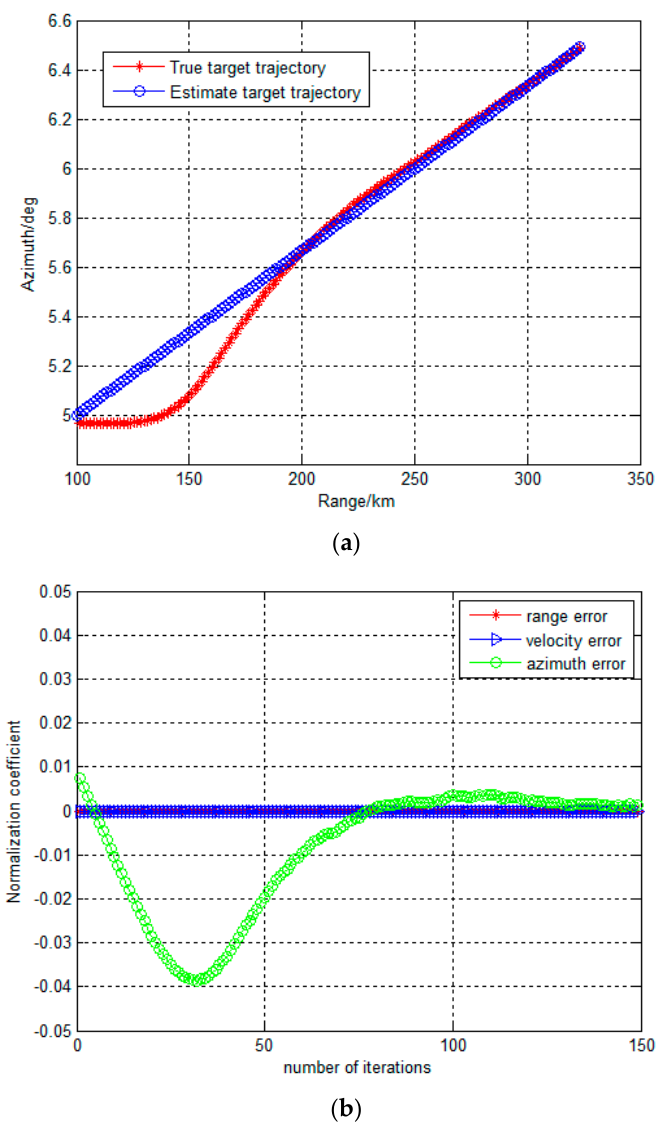
Figure 7. Simulation result when detection probability is 0.4: ( a ) estimate target trajectory compared to true target trajectory; and ( b ) estimate target state error.